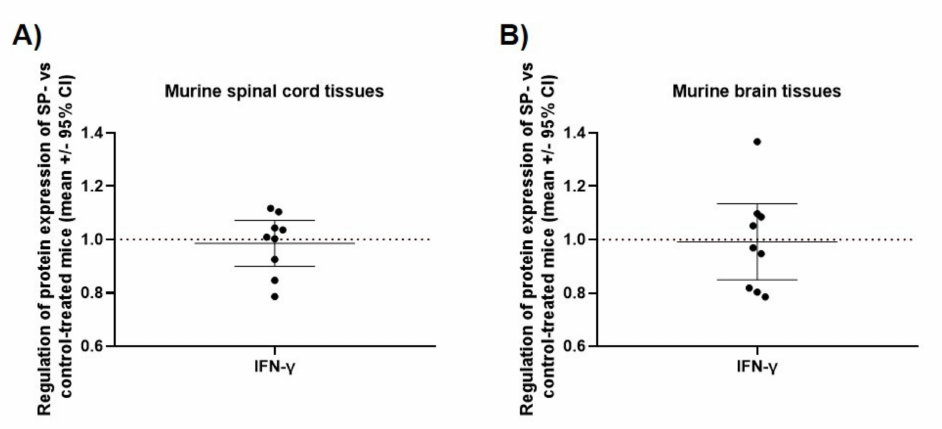
Figure A4. E ff ect of SP treatment on relative cytokine protein INF- γ expression in ( A ) murine spinal cords and in ( B ) murine brains of EAE-diseased mice (acute phase). X-fold di ff erence in the relative expression of INF- γ in SP 30 mg / kg / day-treated mice compared to control mice. Control ( n = 9, in triplicates), SP 30 mg / kg / day ( n = 9, in triplicates) and 3 days of treatment. ELISA. Abbreviations: SP: SP600125 and CI: confidence of interval. Statistic: one-sample t -test: